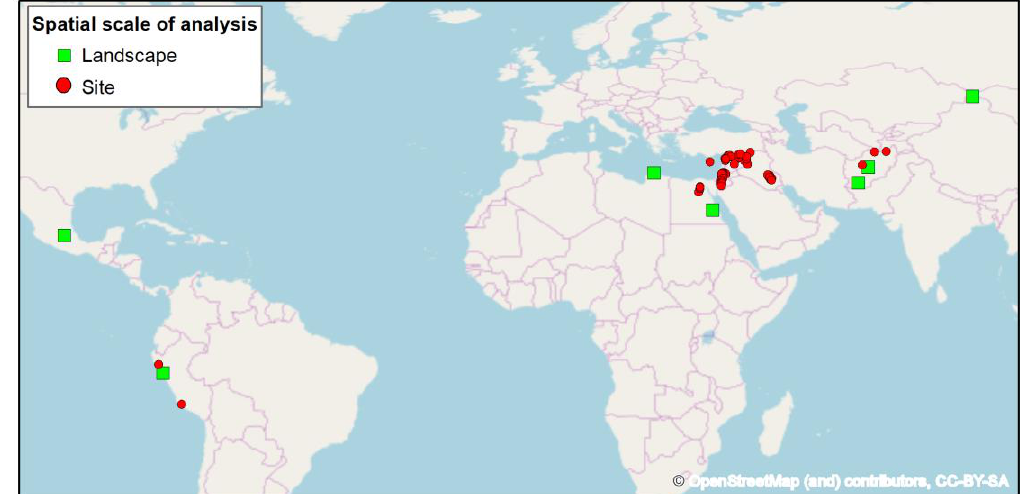
Figure 4. Location of the archaeological sites and cultural landscapes where evidence of looting from satellite imagery was reported in the peer-reviewed papers analyzed in this study (see Figure 2). Publication database updated as of June 2019.